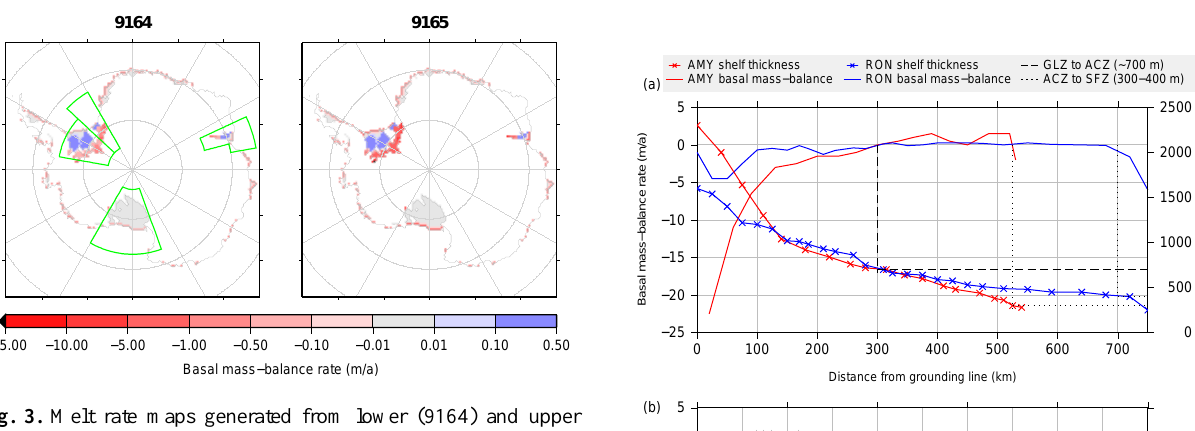
Fig. 3. Melt rate maps generated from lower (9164) and upper (9165) SSM parameter values. The large shelf regions are outlined in green (the latitude, 8 , and longitude, λ , boundaries are AMY = 8( − 75 , − 65 ),λ( 65 , 75 ) and 8( − 75 , − 70 ),λ( 75 , 80 ) ; ROS = 8( − 86 , − 73 ),λ( 160 , 210 ) ; RON = 8( − 85 , − 75 ),λ( 280 , 313 ) and FIL = 8( − 72 , − 85 ),λ( 313 , 330 ) ).